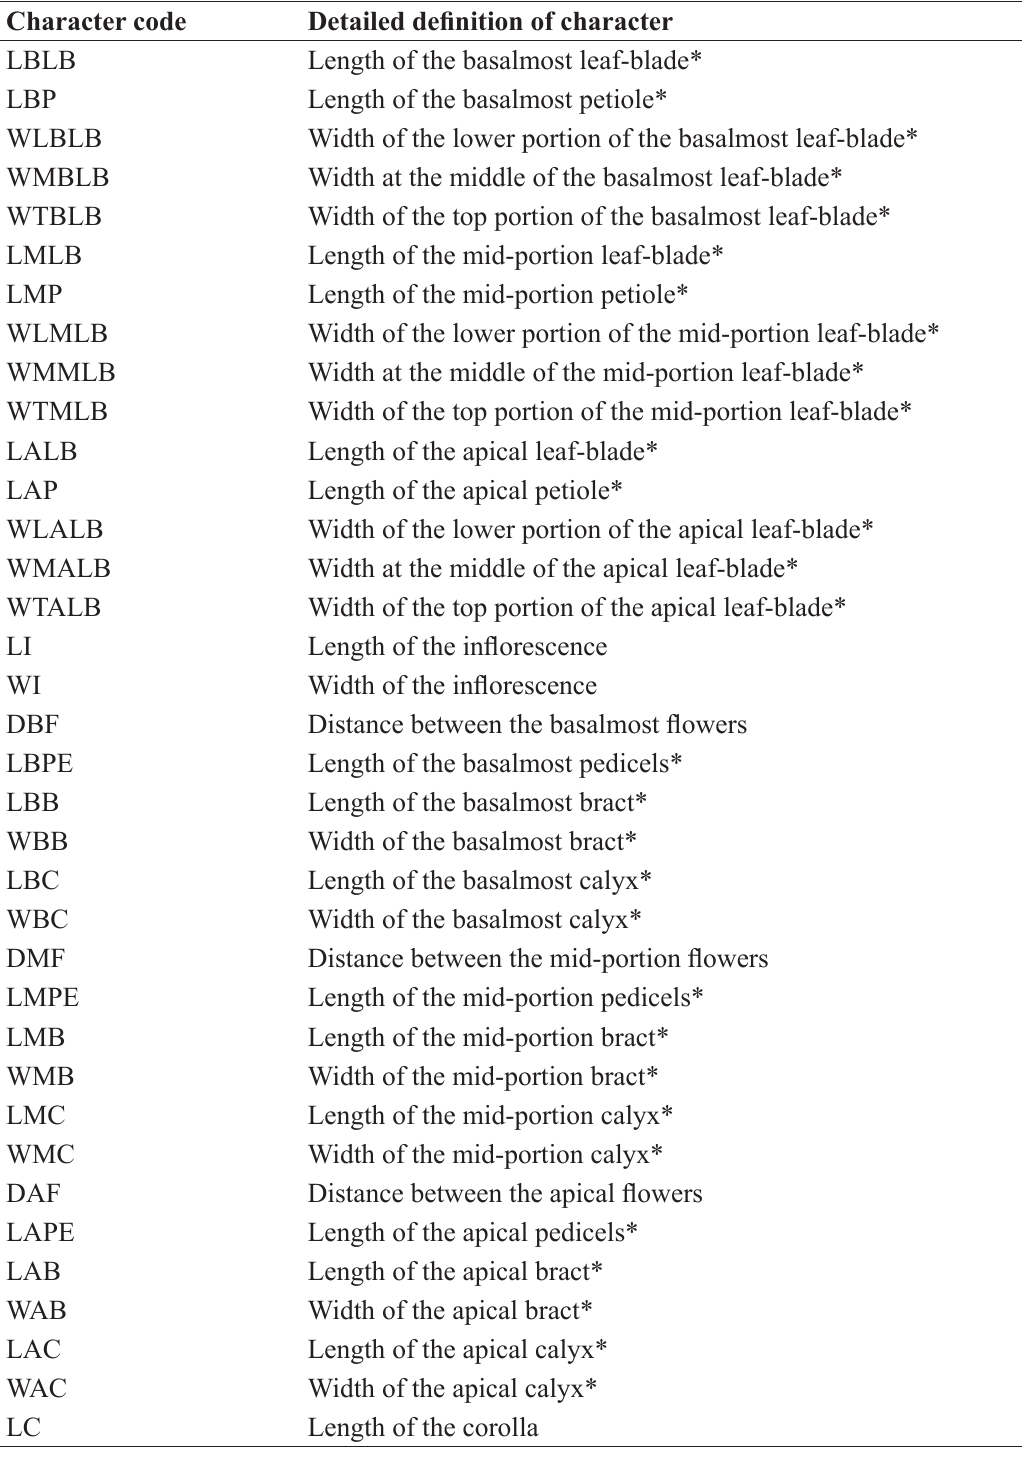
Table 3. Characters used in a multivariate analysis with their codes. Asterisks (*) indicate characters that were averaged from two measurements (on two different leaves/flowers in the same